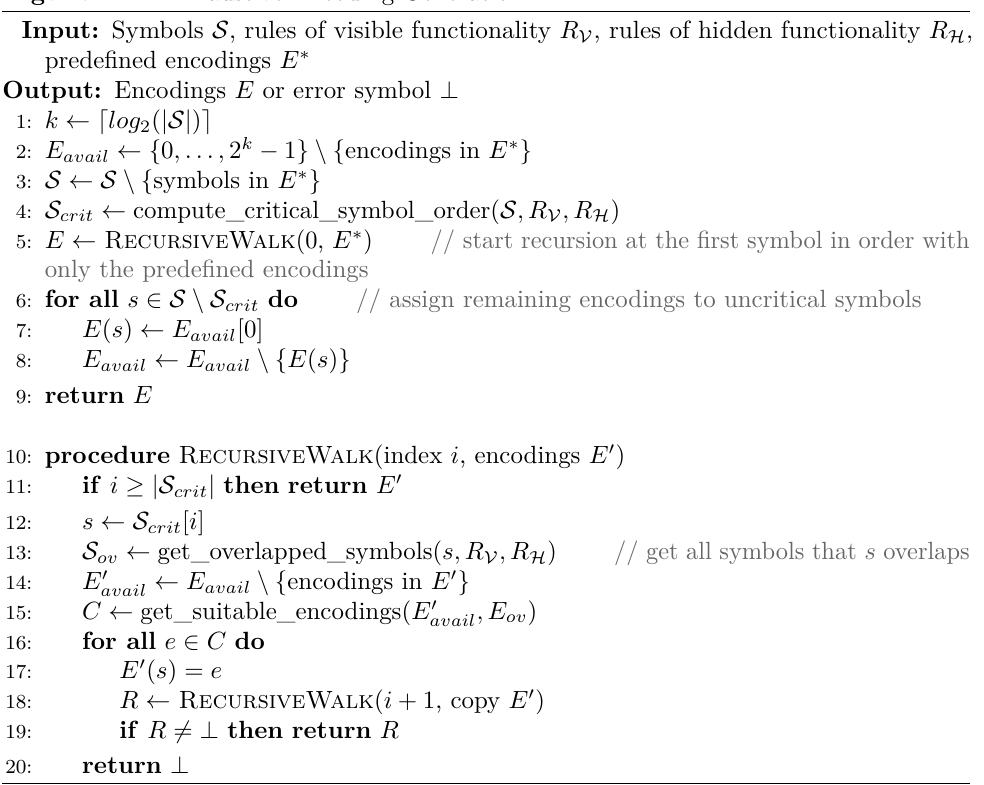
Algorithm 2 Exhaustive Encoding